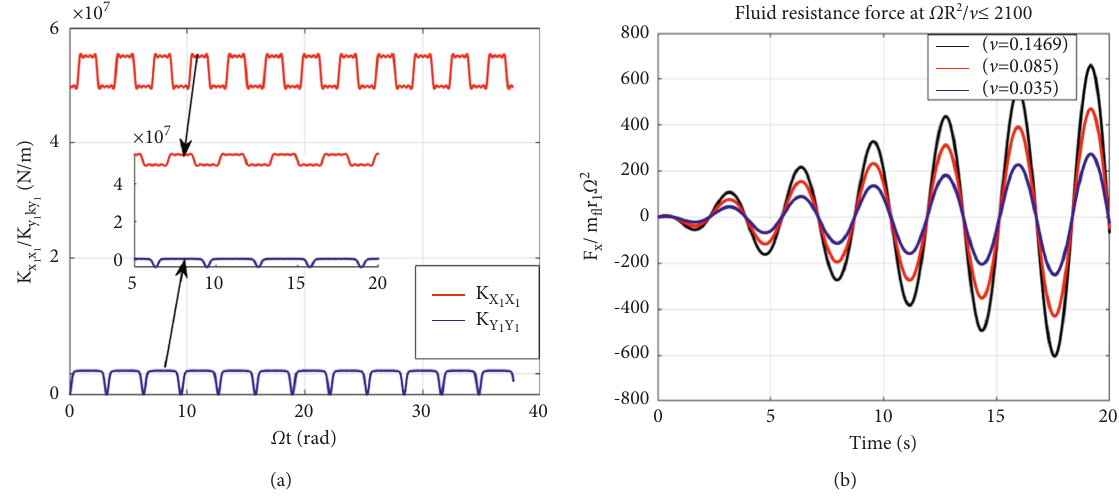
Figure 5: (a) Breathing behaviour of the cracked driveshaft